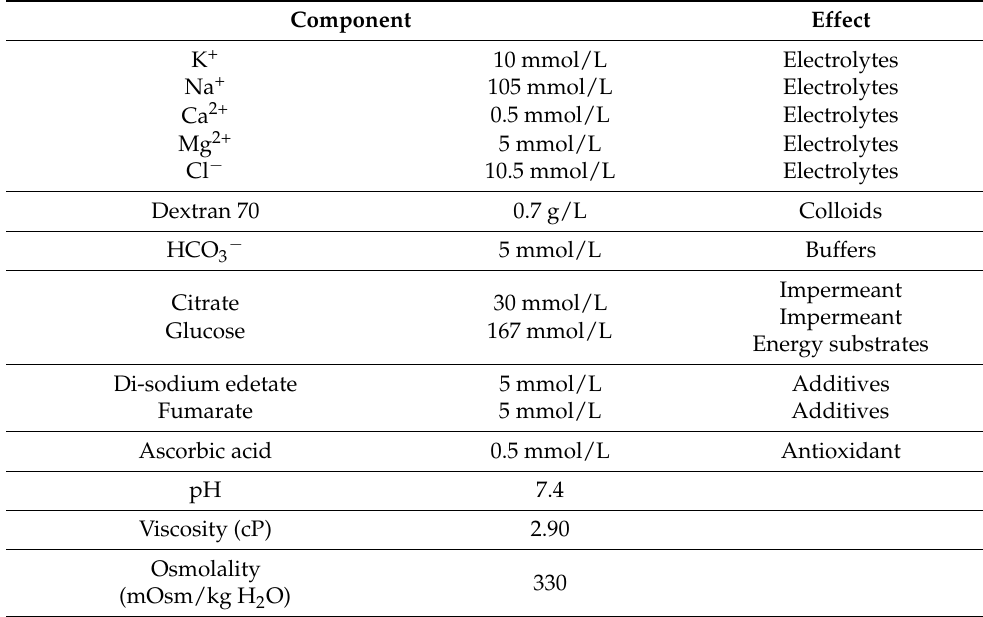
Table 1. The composition and functions of the individual components of Biolasol